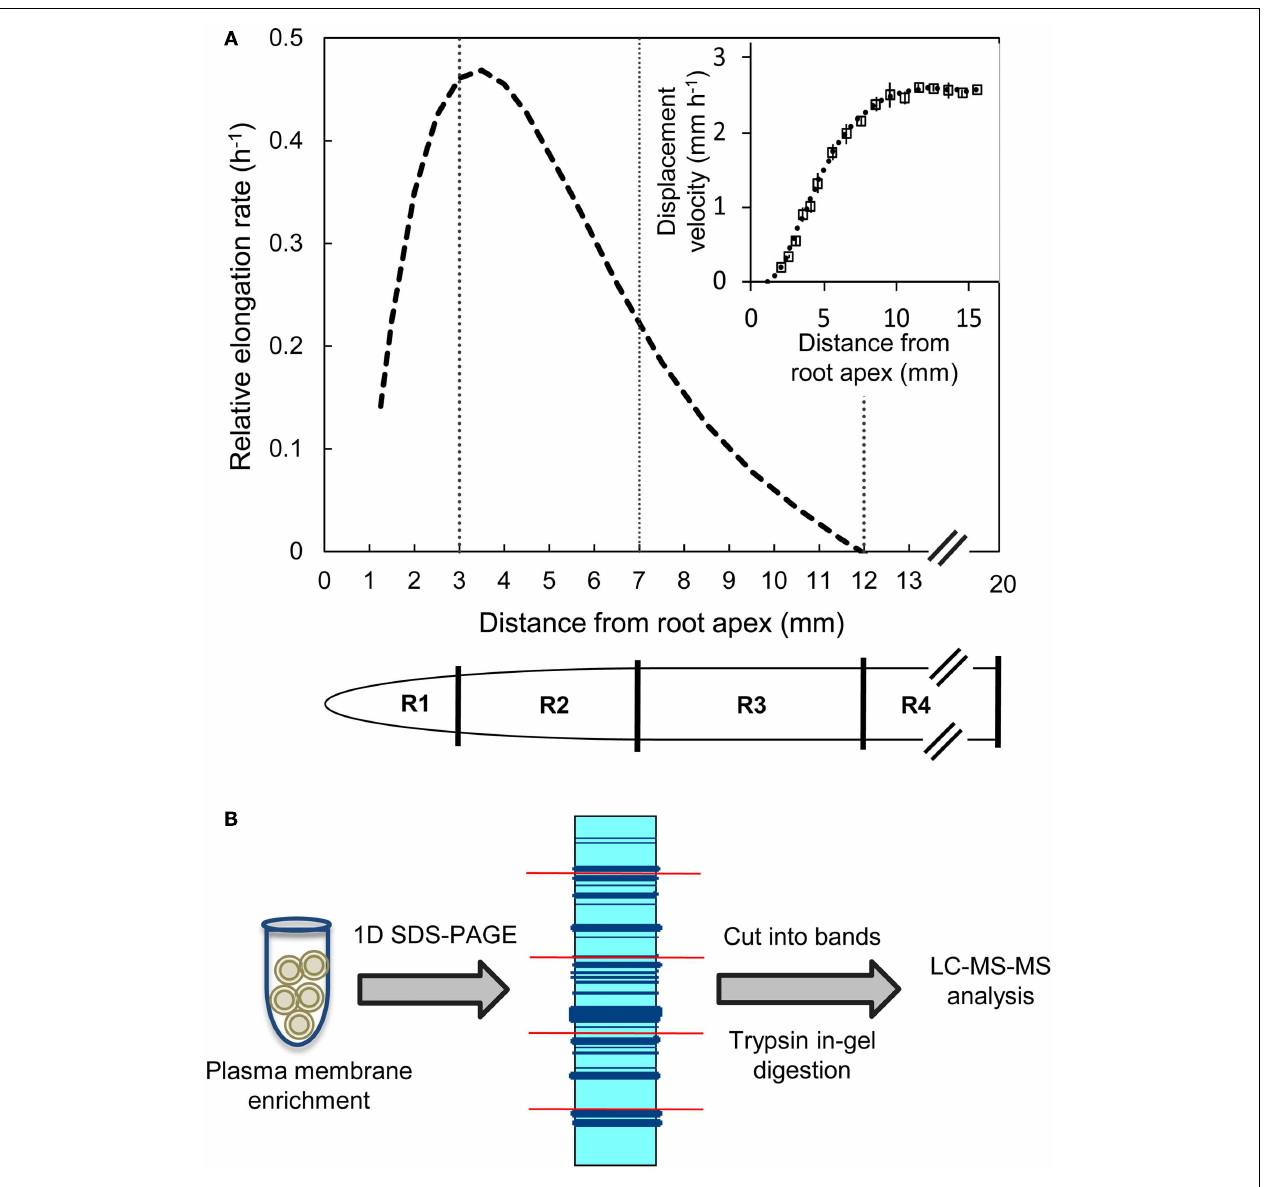
displacement velocity profile and the derivative of displacement velocity against position was used to obtain the relative elongation rate profile (h − 1 ).Tissues from region 1 (R1, 0–3mm), region 2 (R2, 3–7mm), region 3 (R3, 7–12mm), and region 4 (R4, 12–20mm) were harvested. (B) Label-free proteomics work flow shown for plasma membrane-enriched samples as protein input followed by in-gel tryptic digestion and LC-MS/MS